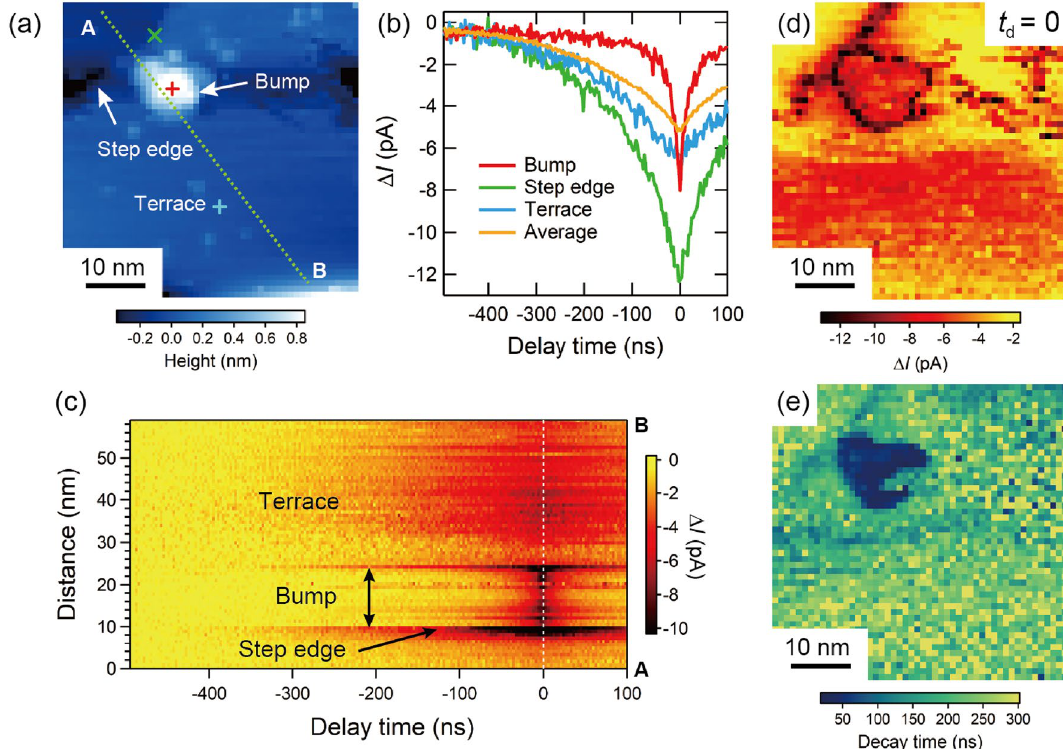
Figure 7. ( a ) STM image of GaAs(110) surface. Set-point: V = + 3 V, I t = 100 pA. T = 6 K. (b) Characteristic spatially-dependent OPP tunneling current–delay time curves. The locations where the curves are taken are shown in ( a ) indicated with the same color. Laser power is 0.25 mW. ( c ) Line curves along A-B in ( a ). The step of delay time is 3 ns, and the averaging time at each delay time is 0.15 s in ( b ) and ( c ). ( d ) OPP tunneling current map at a delay time of 0 ns measured in the same field of view with ( a ). ( e ) Decay time map in the same field of view with ( a ). The decay time at each location is estimated by fitting the spectrum with a single exponential